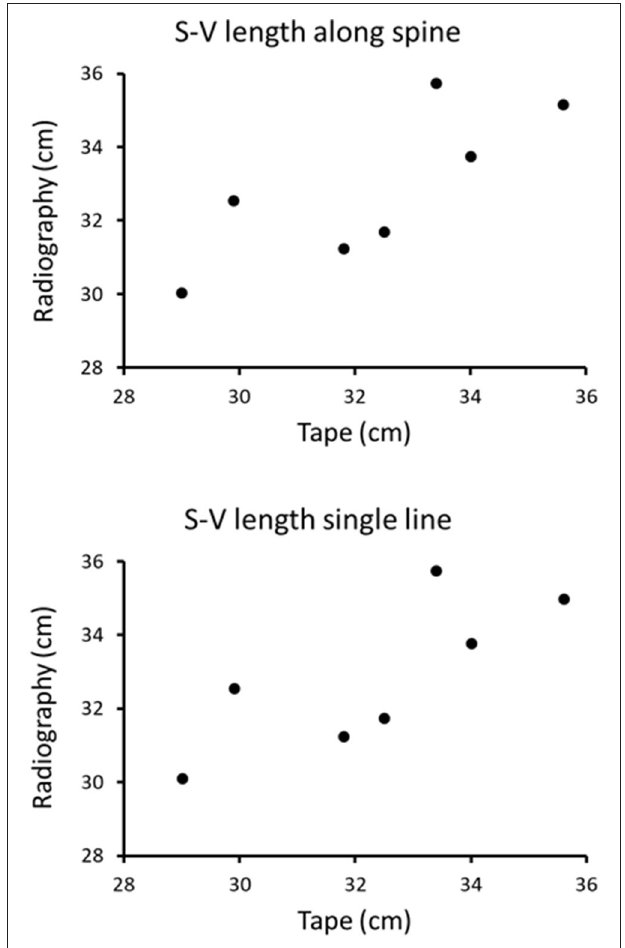
FIGURE 3 | Snout-vent length of marine iguanas measured using tape compared to the snout-vent length measured using radiography along the vertebral column (Top) and using a single measurement line (Bottom)